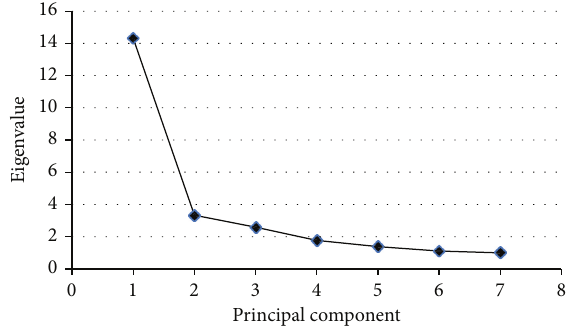
Figure 6: Scree plot for the first seven eigenvalues and the corre- sponding error bars at 5% significance level resulting from the S- mode PCA applied to (a) the